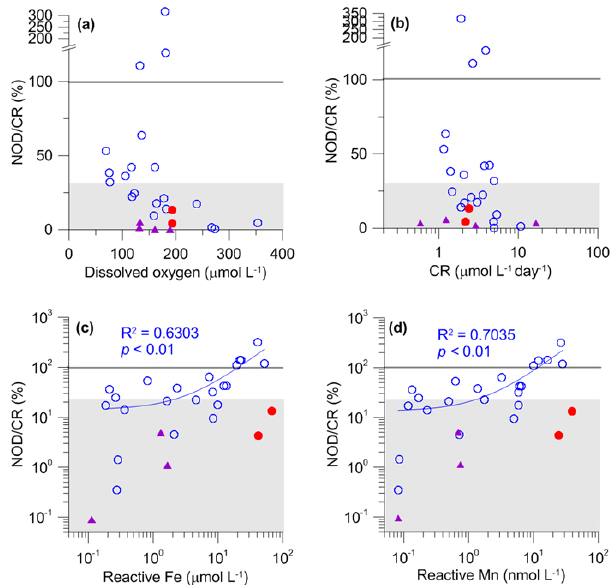
Fig. 5. Scatter plots of the percentage of nitrification-associated oxygen demand in CR against (a) dissolved oxygen, (b) commu- nity respiration rate, (c) reactive Fe and (d) reactive Mn for the river mouth ( • ), the inner plume ( ◦ ) and the outer plume ( N ). Data for the Qiantang river mouth and Y4 station were not included because of a lack of CR data. The shaded zone with the upper limit of 23.2% indicates the theoretical estimate by the Redfield model. The hori- zontal line refers to 100% CR. Note that both axes in (c) and (d) are in log 10